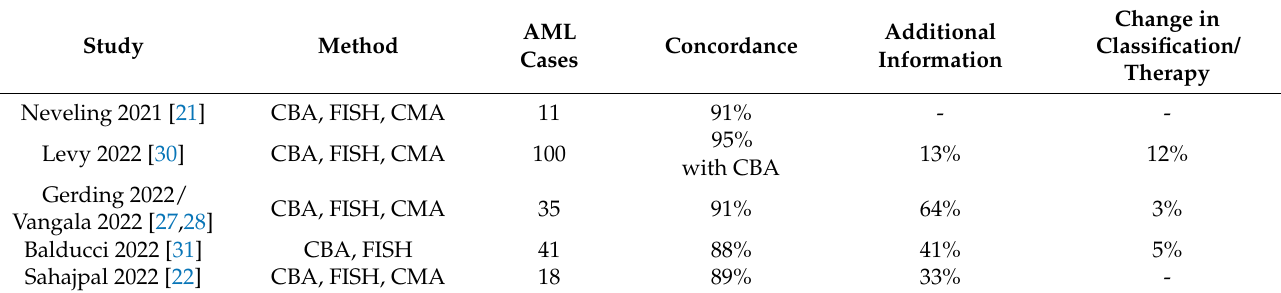
Table 2. Overview of studies evaluating use of OGM for adult AML diagnostics. Due to the slightly different study designs and analyses employed, the classification of cases with “additional information” varies. Additional information consists of variants that were not detected by routine diagnostics or variants that were unclear and could be specified after routine diagnostics (CBA— Chromosomal Banding Analysis; FISH—fluorescence in situ hybridization; and CMA—CNV mi- croarray)